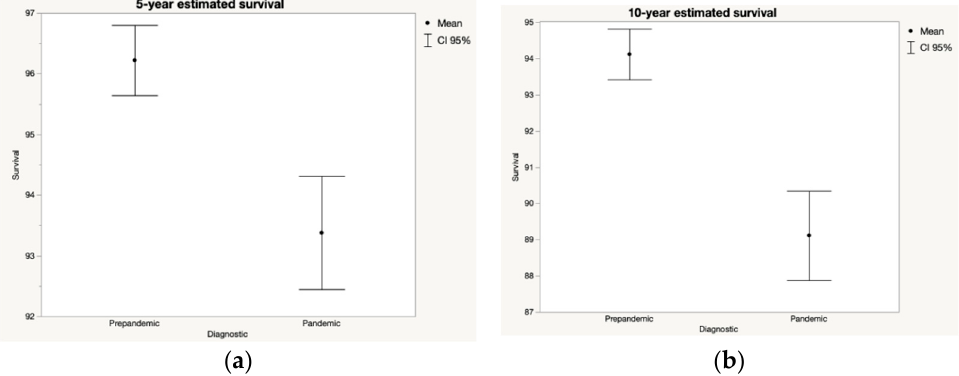
Figure 2. 5-year ( a ) and 10-year ( b ) estimated survival according to AJCC 2018 staging system of the patients with malignant melanoma that were diagnosed before and after the onset of the SARS-CoV-2 pandemic. Considering tumor staging, a lower mid-term and long-term survival of patients diagnosed with melanoma after the onset of lockdown might be observed.